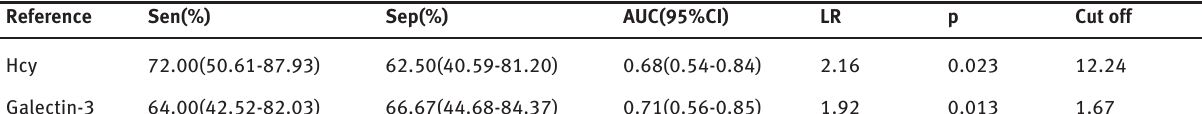
Table 5: The diagnostic efficacy of serum Hcy and Galectin-3 as biomarker for diagnosis of PeAF. Reference